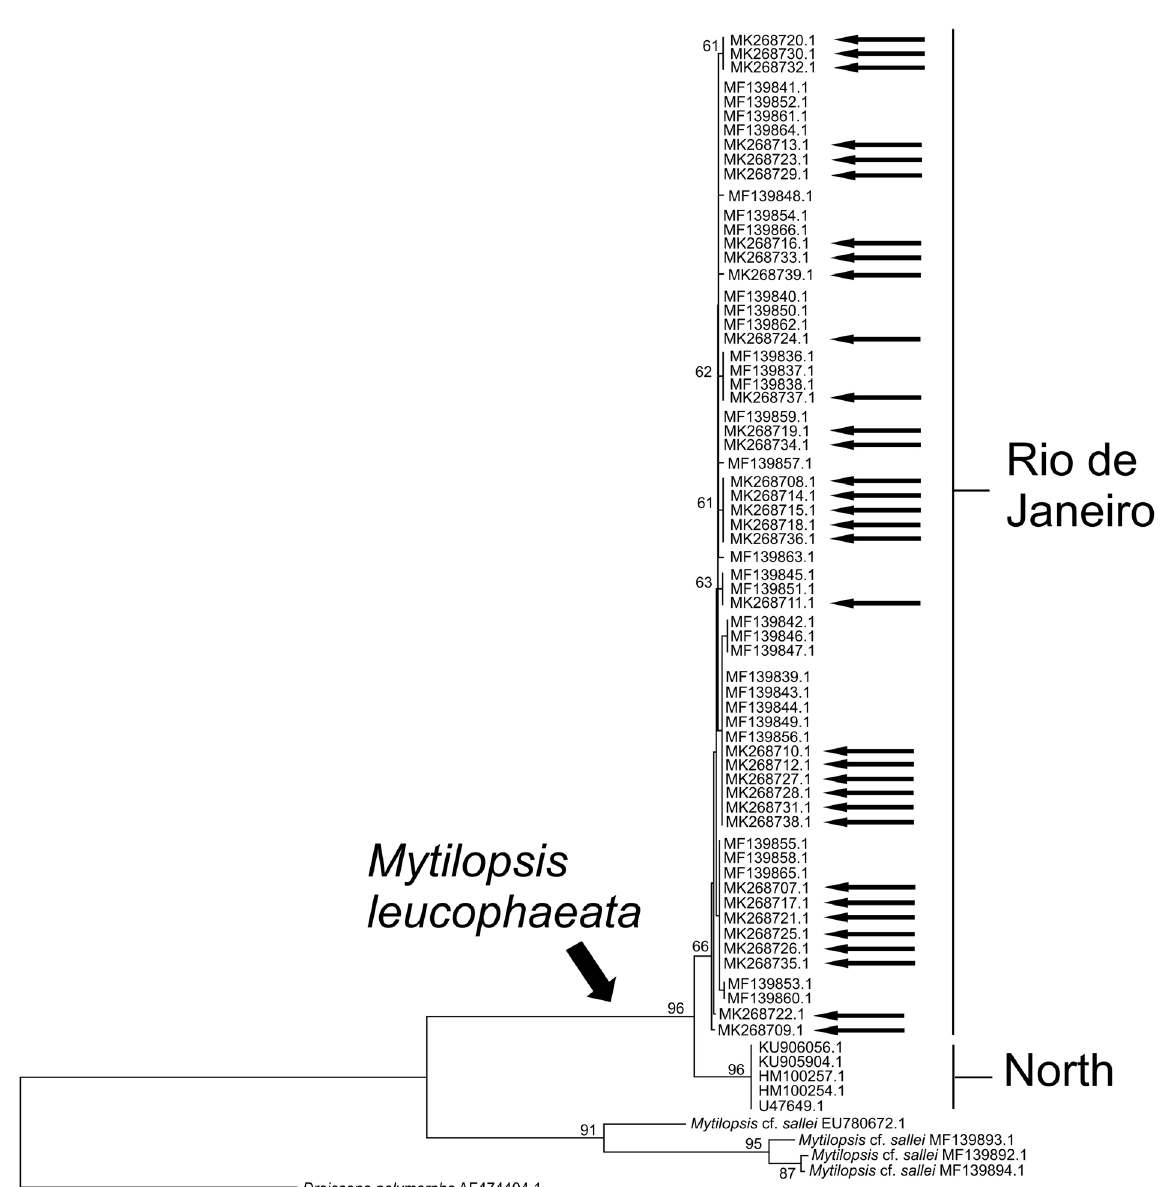
Figure 5. Maximum-likelihood tree based on COI sequences, rooted in D . polymorpha . The population of M . leucophaeata named ‘Rio de Janeiro’ comprises records from Marapendi (indicated by black arrows) and Rodrigo de Freitas lagoons, whereas ‘North’ comprises sequences from northeastern U.S.A., Germany and Caspian Sea. Indices of bootstrap (%) displayed only for clades recovered with more than 60% of